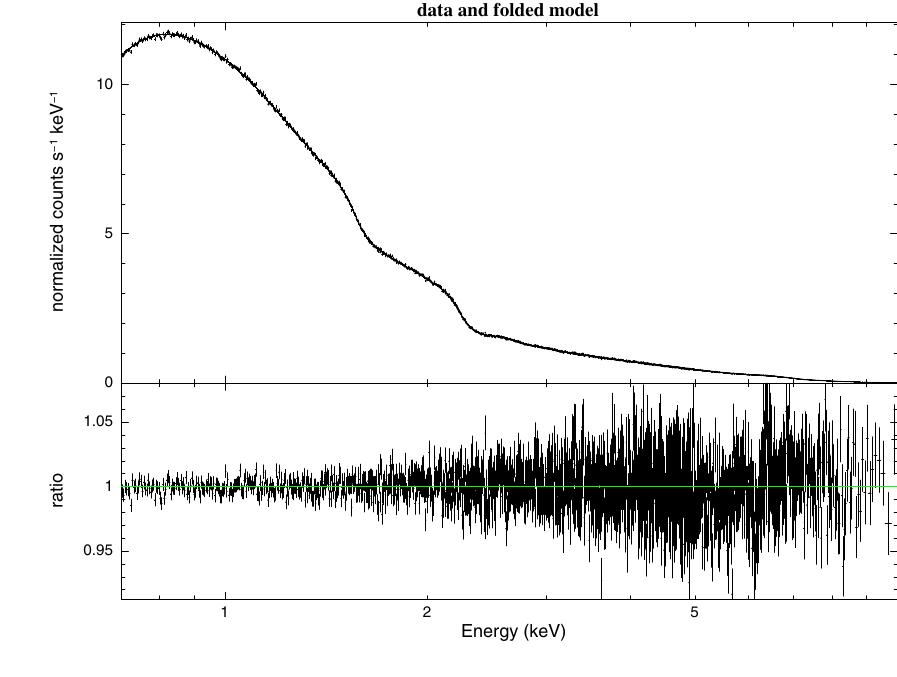
Fig. 4 Top panel simulated data and best fit of the observed spectrum assuming that the source is a bright AGN. Bottom panel ratio between the simulated data and the best fit. The spectrum of the source is computed assuming the Bonnor metric with h = − 0 . 1. The viewing angle is i = 45 ◦ and the exposure time is τ = 1 Ms. The minimum of the reduced χ 2 is about 1.07. See the text for more